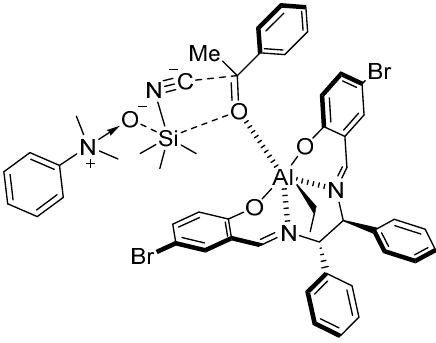
Figure 4. Proposed transition state for addition CN to imines.